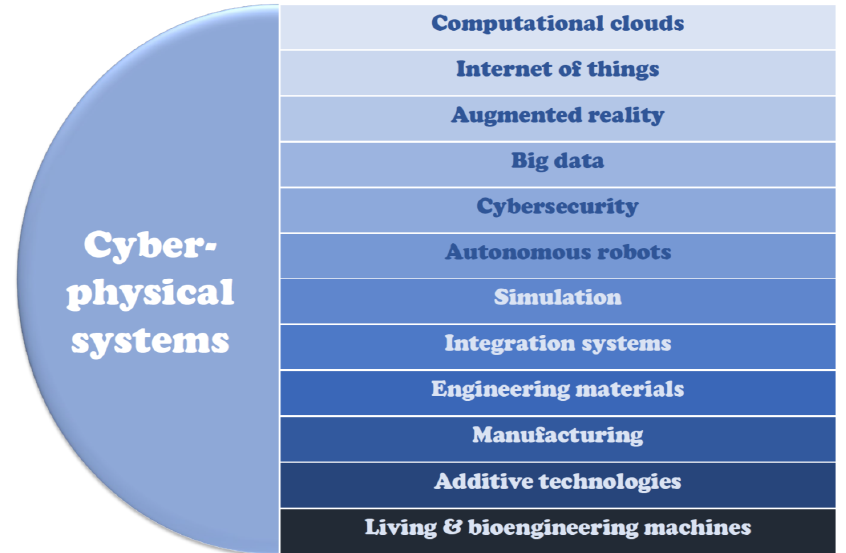
Figure 12. The supplemented diagram of the technologies underlying the assumptions of Industry 4.0.